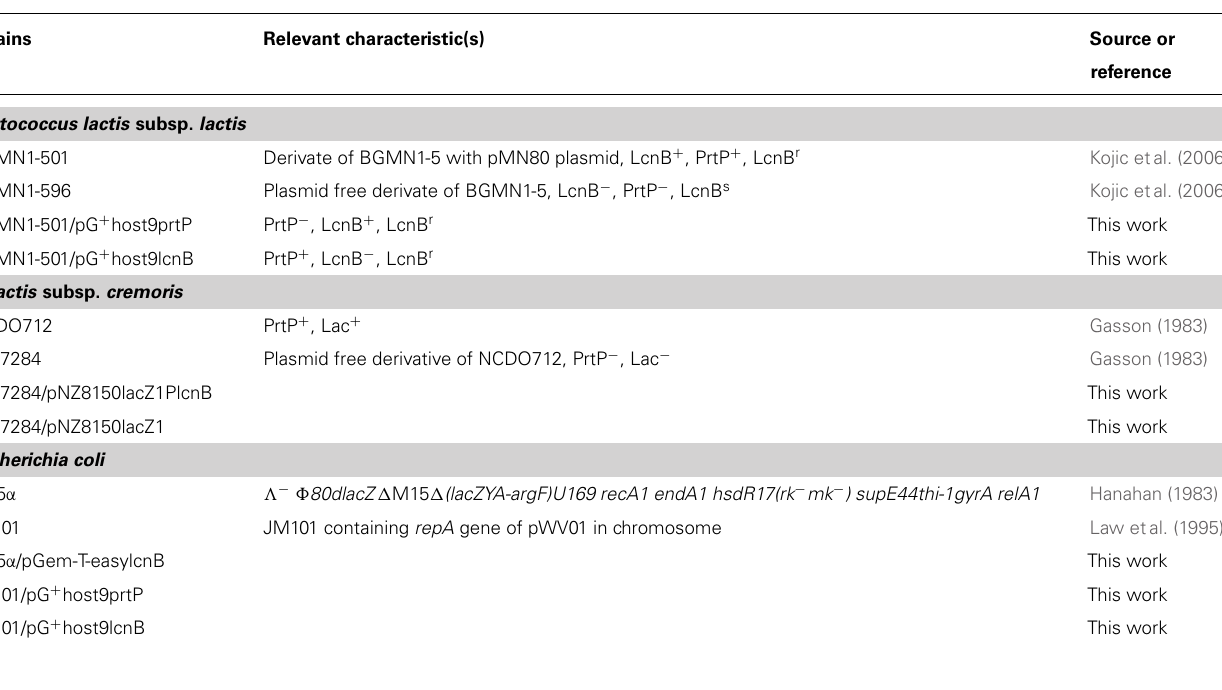
Table 1 | Bacterial strains used in this study. Strains Relevant